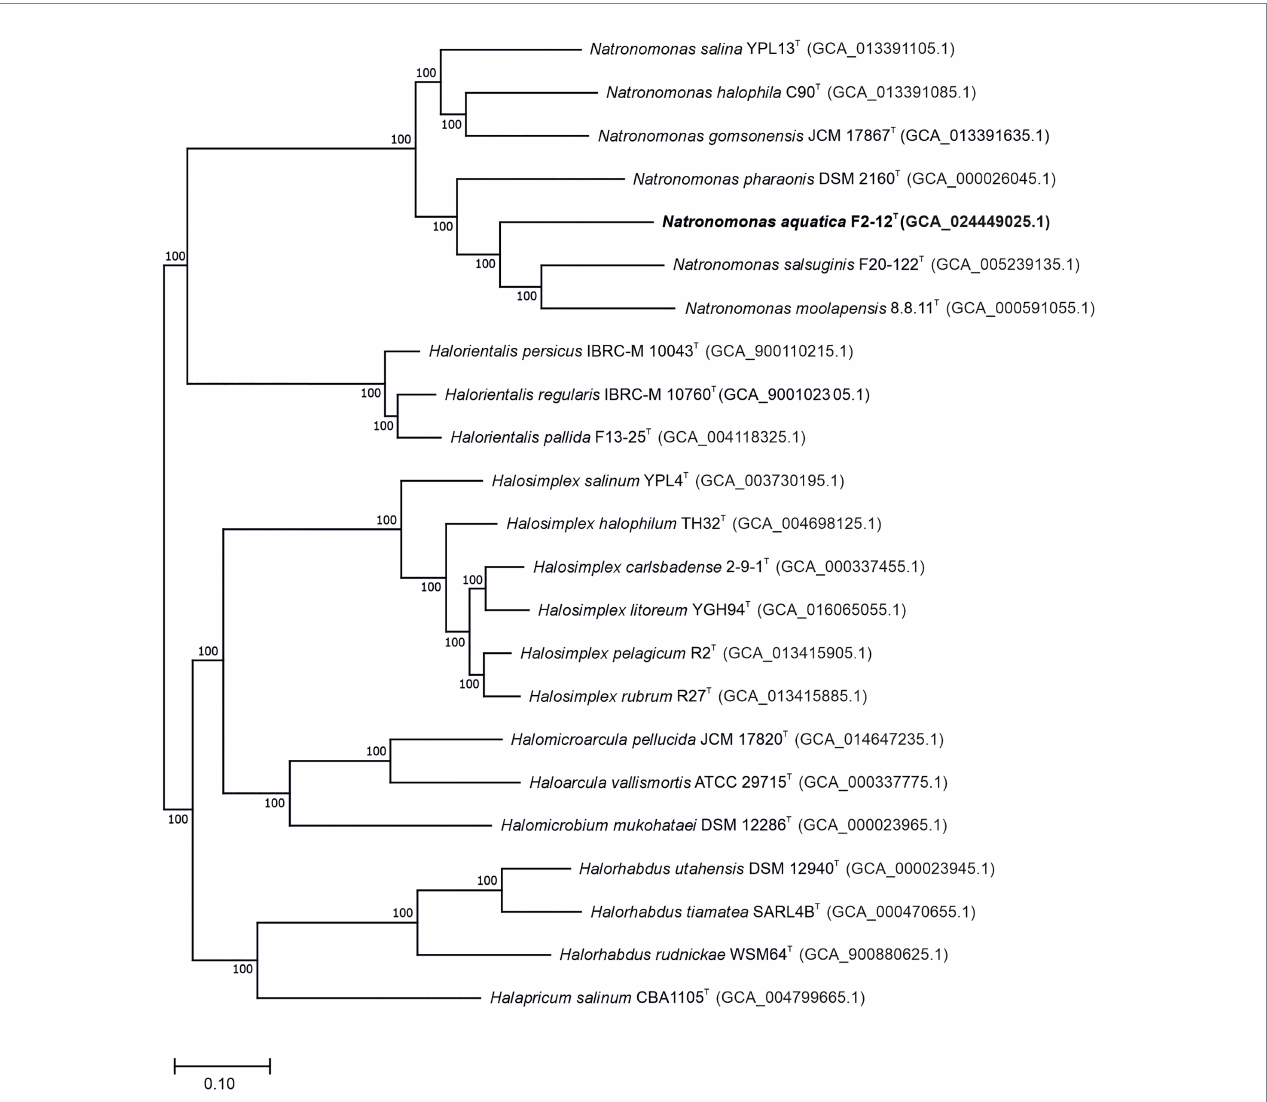
FIGURE 1 Approximately maximum-likelihood phylogenomic tree reconstruction based on the translated core orthologous genes of members of the genus Natronomonas , including strain F2-12 T and related species. This tree was obtained after the alignment and concatenation of the translated sequences of 870 shared orthologous single-copy genes of these genomes. Bootstrap values higher than 70% are indicated at branch points. Bar, 0.1 substitutions per nucleotide